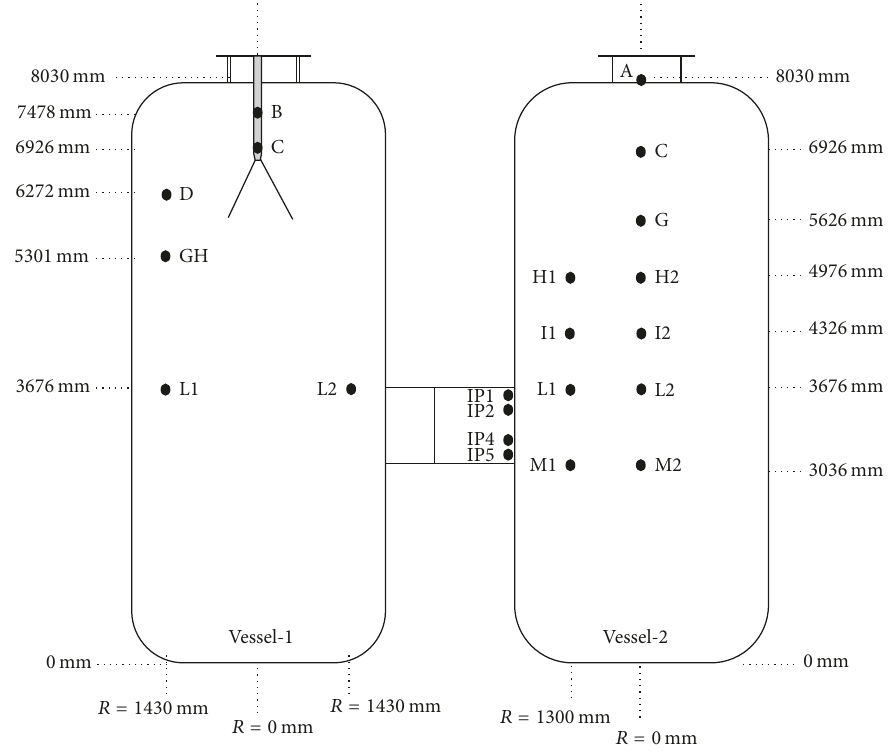
Figure 8: Probes locations in PANDA test 25.